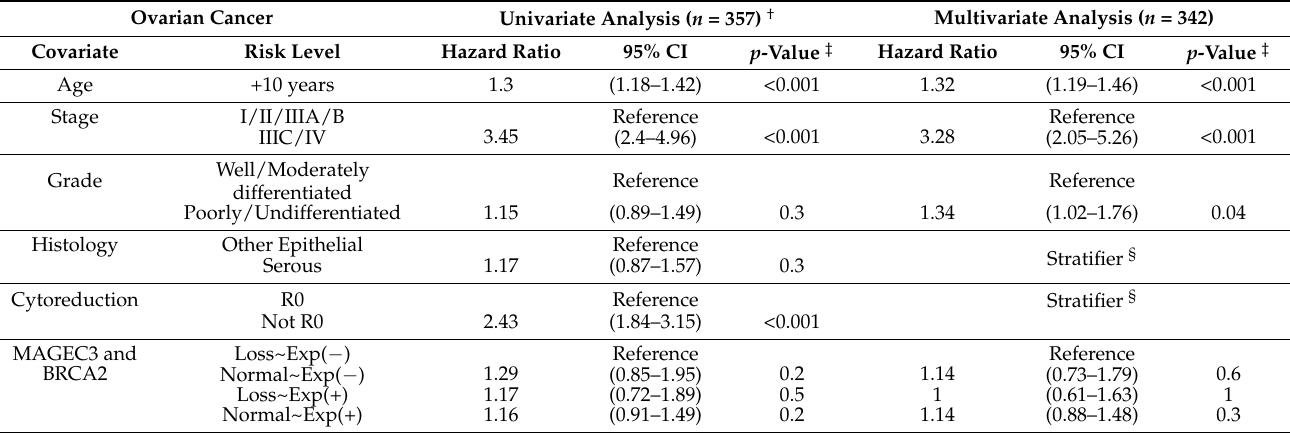
Table 2. Discovery cohort survival